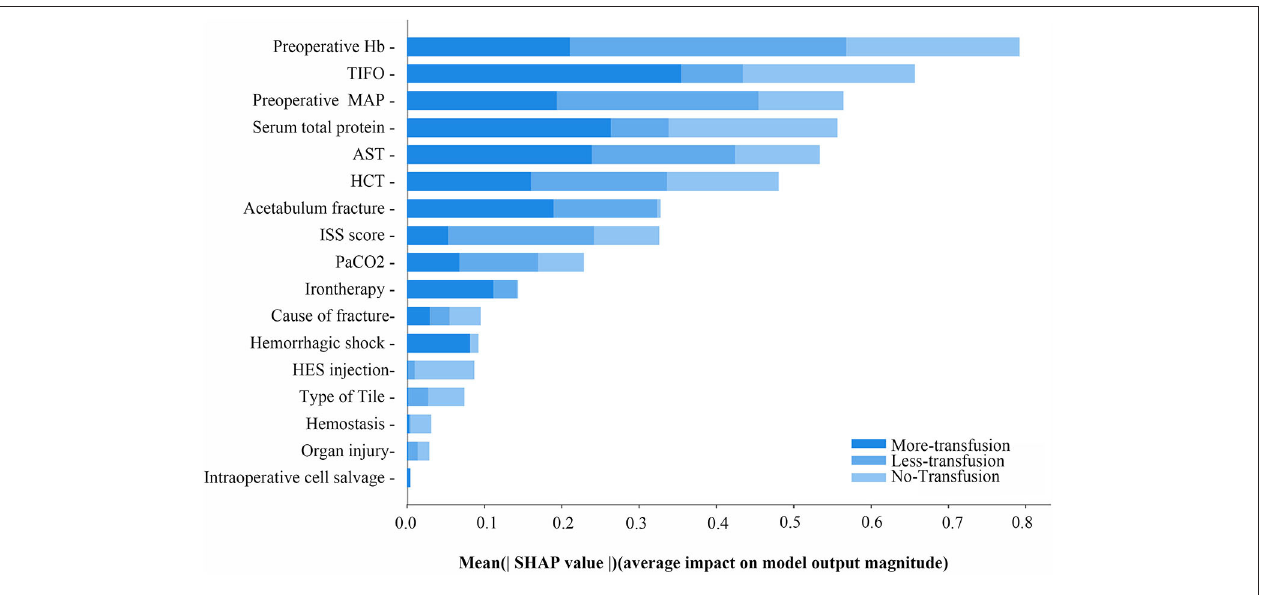
FIGURE 3 | The mean SHAP value of variables in RBCs transfusion predictive model of ternary classifications. MAP, preoperative mean arterial pressure; TIFO, time from the injury and the first operation; AST, aspartate transaminase; HCT, hematocrit; ISS, injury severe score; PaCO 2 , partial pressure of carbon dioxide; HES, hydroxyethyl starch.